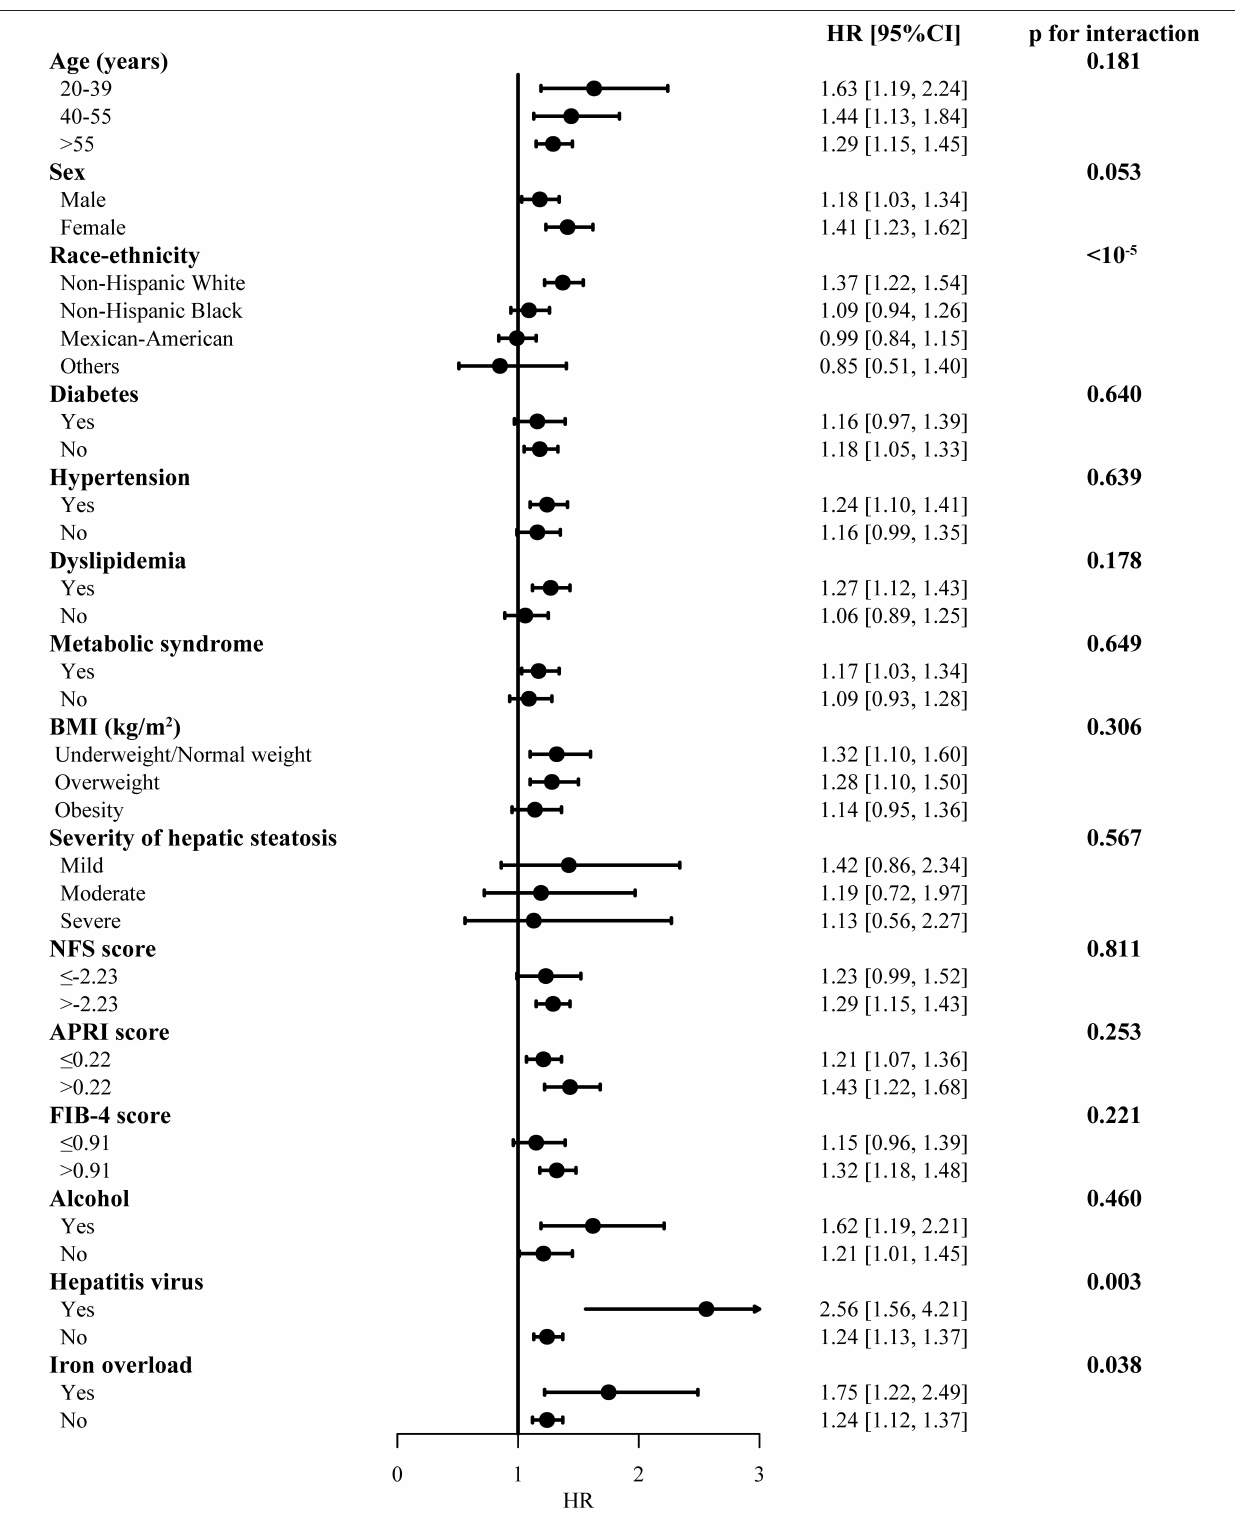
FIGURE 3 | Subgroup analysis for the overall mortality in participants with MAFLD. The model was adjusted by adjusted by age, sex and race-ethnicity. MAFLD, metabolic dysfunction-associated fatty liver disease, compared with non-MAFLD participants; BMI, body mass index; HR, hazard ratio; CI, confidence internal. Significance was determined as p < 0.0033 (Bonferroni correction